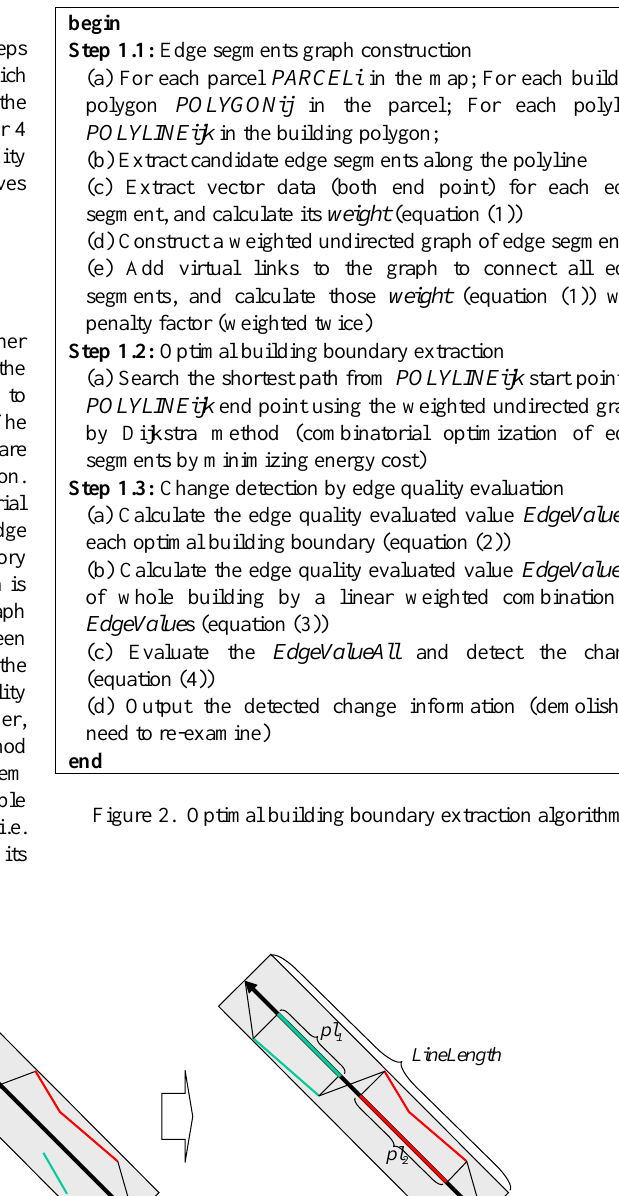
Figure 3. Optimal building boundary